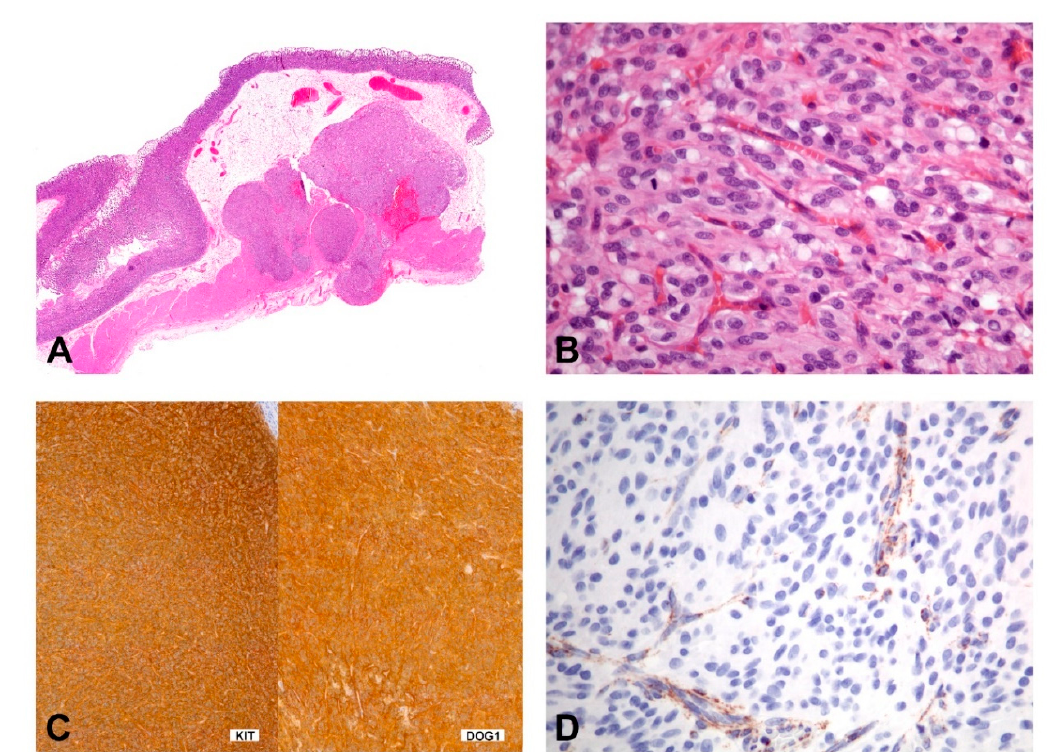
Figure 8. Morphology and immunohistochemical findings in SDHB-deficient GIST. ( A ) The gastric tumor with multilobulated/plexiform growth pattern. ( B ) The tumor is composed of epithelioid cells with a syncytial appearance. ( C , D ) Immunohistochemically, the tumor shows positivity for KIT and DOG1 ( C ), while the expression of SDHB is lost ( D ); the cytoplasmic stain of the endothelial cells shows the positive internal control).